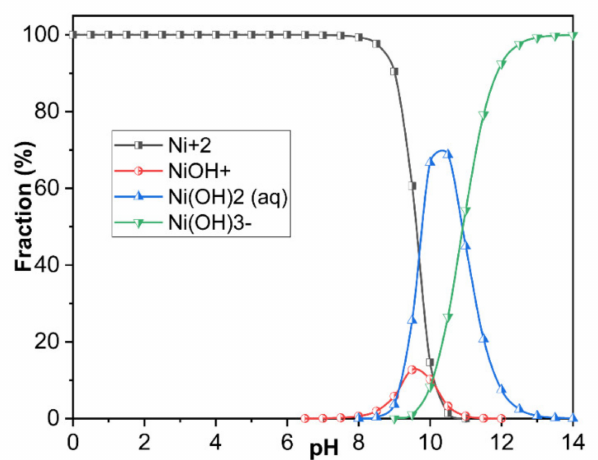
Figure 8. The results of the thermodynamic simulations of the hydrolyzed species of Ni ions in the pH range from 1 to 14.